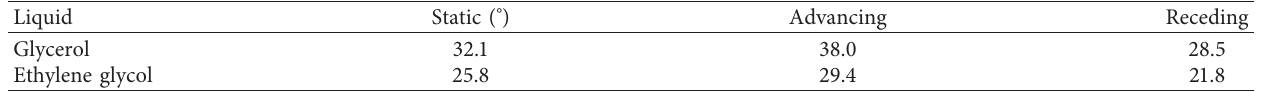
Table 4: Test conditions.